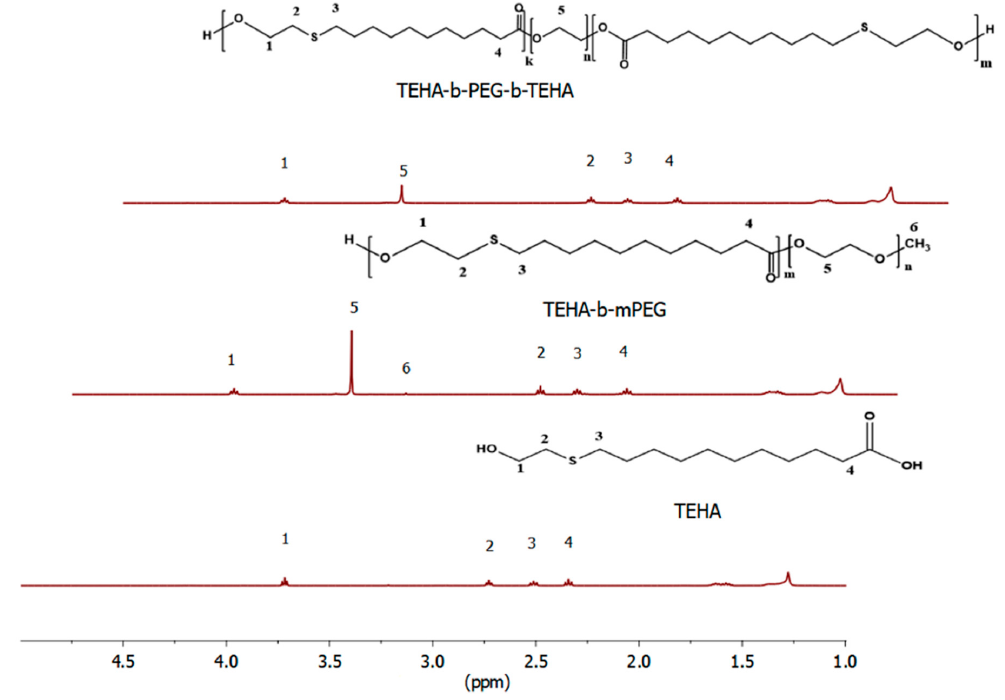
Figure 2. 1 H-NMR spectra of TEHA, TEHA-b-mPEG diblock, and TEHA-b-PEG-b-TEHA triblock copolymers.